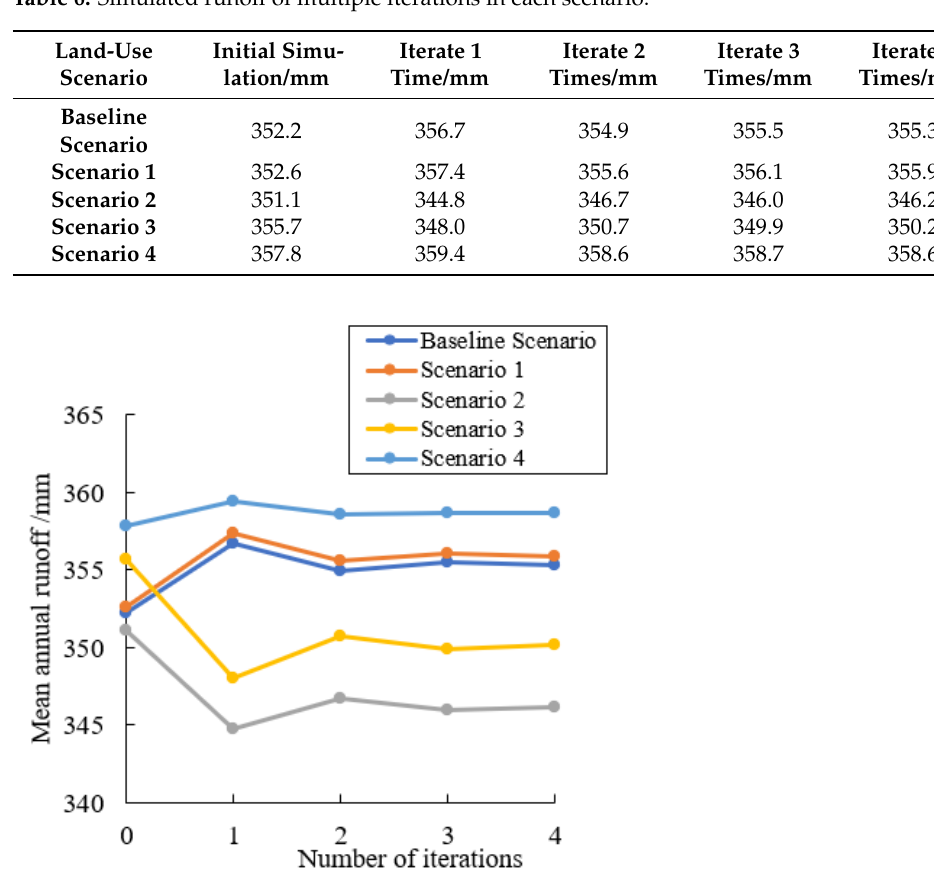
Table 6. Simulated runoff of multiple iterations in each scenario.